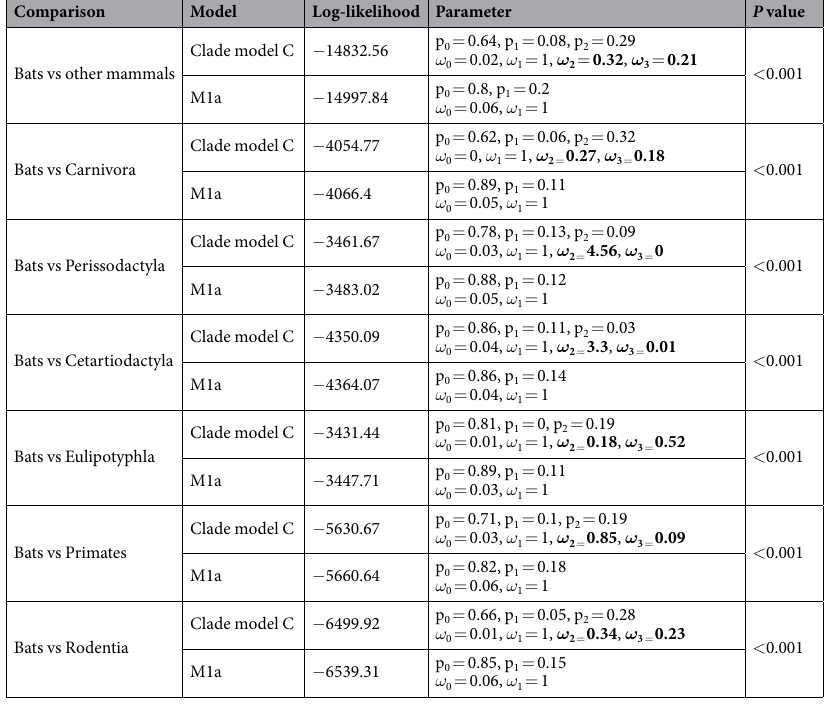
sensory trade-off hypothesis, between vision and echolocation, was proposed for rhinolophid and hipposiderid bats that utilize specialized high duty cycle echolocation to explain the loss of the SWS1 gene in these species 20 . To examine selective pressure (ratio of non-synonymous and synonymous substitution rates, or ω ) acting on bat SWS1 pigments, we first carried out an evolutionary analysis of the SWS1 sequences (no pseudogenes included) from both bats and other mammals (Supplementary Fig. 2A). Results from the clade model C analysis using PAML 4.9 show a subset of sites that are under different selective pressure in bats ( ω = 0.21) compared to other mammalian species (0.32) ( P < 0.001). Notably, even sites in SWS1 that are under purifying selection in both groups are more strongly conserved in bats. Additional comparisons between bats and species from single orders (i.e., Carnivora, Perissodactyla, Cetartiodactyla, Eulipotyphla, Primates and Rodentia) retain support the conclusion that the SWS1 genes in bats experienced stronger purifying selection than in other mammals, with the exception of eulipotyphlans (Table 1). A sliding window analysis was then conducted to calculate the ω values for species from each order. Results of this analysis show that the estimated ω values are higher in species from the orders Carnivora, Perissodactyla, Cetartiodactyla and Primates than in bats, while no obvious difference among bats, eulipotyphlans and rodents (Supplementary Fig. 2B), which is a pattern similar to that derived from clade model C. Previous findings, based on other evolutionary models in PAML, have shown purifying selection on bat SWS1 genes 20,22 . The results of our study further reveal that the negative selection acting on bat SWS1 is even stronger than on other mammals (except eulipotyphlan species), which suggests that the spectral sensitivities of SWS1 pigments from these bats have probably not shifted much.